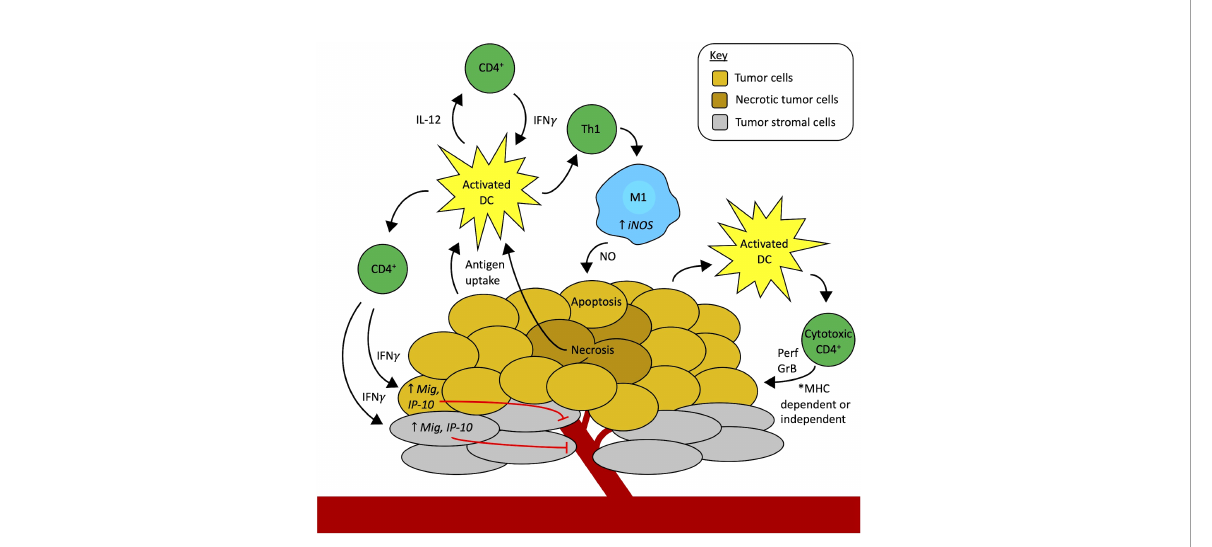
FIGURE 1 Mechanisms of CD4+ T cells as effectors of antitumor immunity independent of CD8+ T cells. Professional antigen-presenting cells (APCs), like activated dendritic cells (DCs, yellow), in the tumor microenvironment (TME) take up tumor antigens. Starting on the left-hand side of the fi